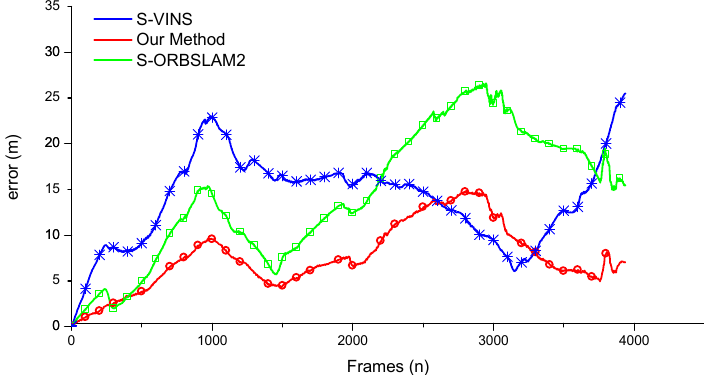
Figure 13. Error curves of varied methods comparing with the ground truth. The horizontal coordinate of the figure was the frame sequences of the camera. The vertical coordinate was the bias value between the ground truth and the estimation in the corresponding frame ( close to the zero line means the error was